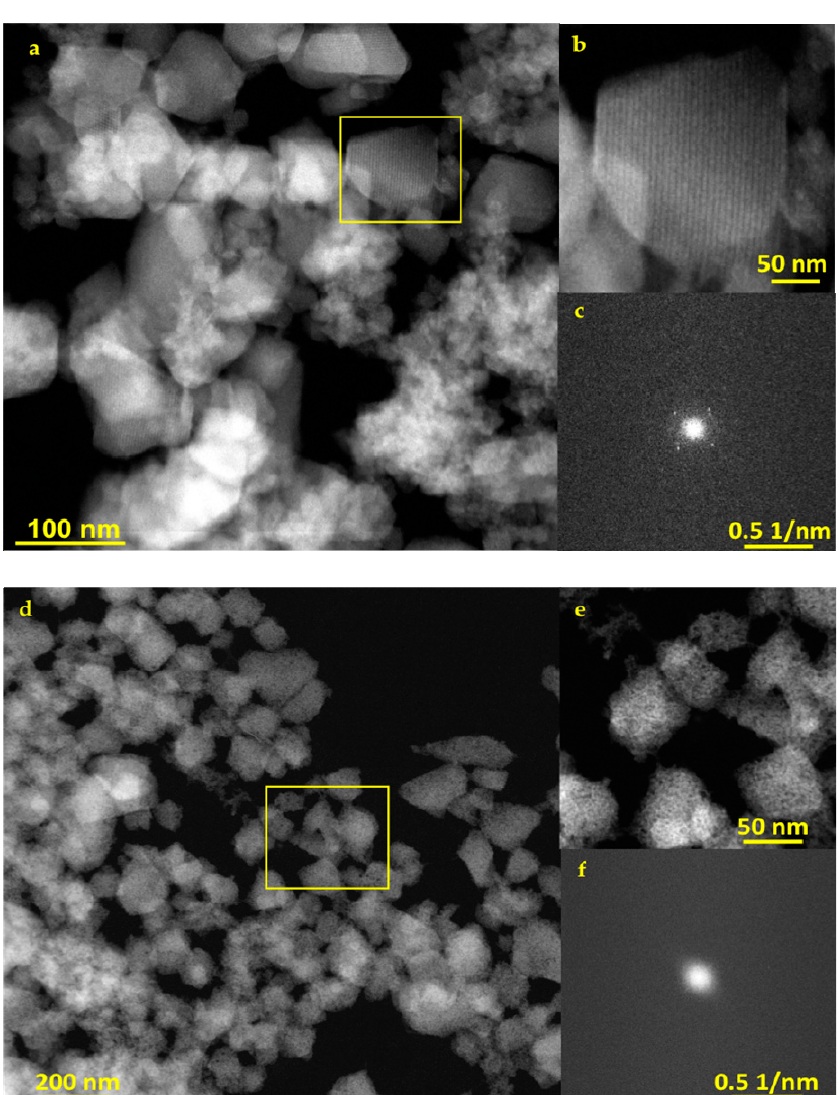
Figure 2. ( a , b ), STEM-HAADF images of degraded MIL-100(Fe) nanoMOFs in PBS (pH = 5.4) ( d , e ) in PBS (pH = 7.4) ( c , f ) FFT patterns of MIL-100(Fe) nanoMOFs in PBS pH = 5.4 and pH = 7.4, respectively.